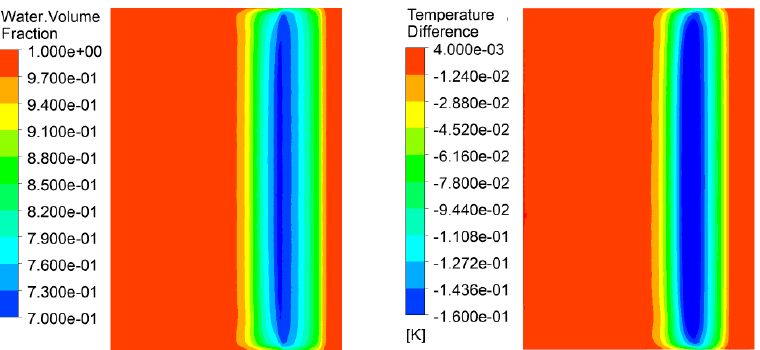
Figure 15. Distribution of water volume fraction and temperature difference on upper side of hydrofoil, σ = 1.83. CFD.